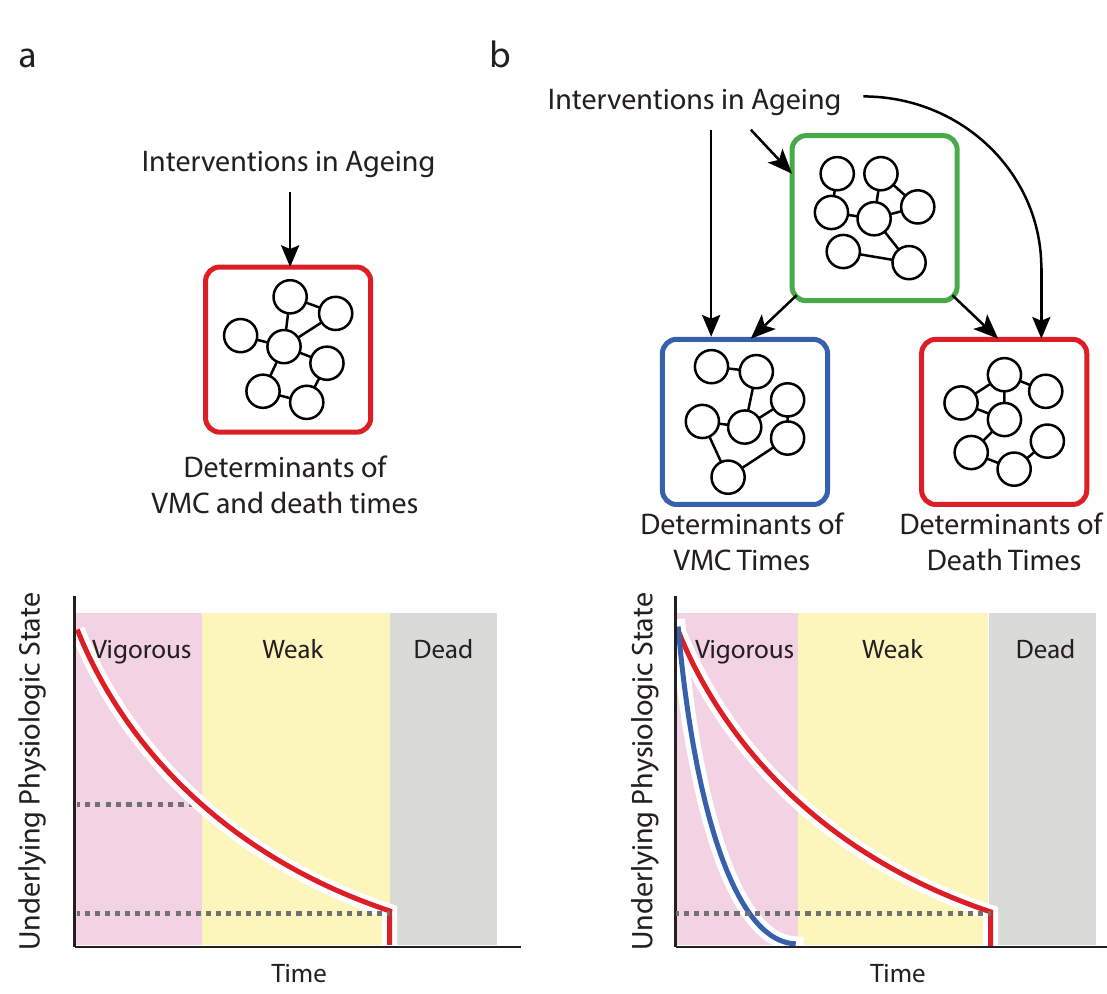
Fig 7. A hierarchical model of vigorous movement and lifespan. a. In a simple, null model, the correlation between vigorous movement cessation (VMC) and death times arises because the two events share physiologic determinants (red box) such that VMC and death represent sequential manifestations of a single underlying aging process (red line in the graph). b. However, our data and modelling suggest that VMC and death times are instead determined by distinct sets of physiologic determinants (red and blue boxes) with each set subject to a distinct aging process (red and blue lines in the graph). In this case, a hierarchical organization among processes allows interventions to act directly on each process, or indirectly through an influence on shared upstream factors (green box).